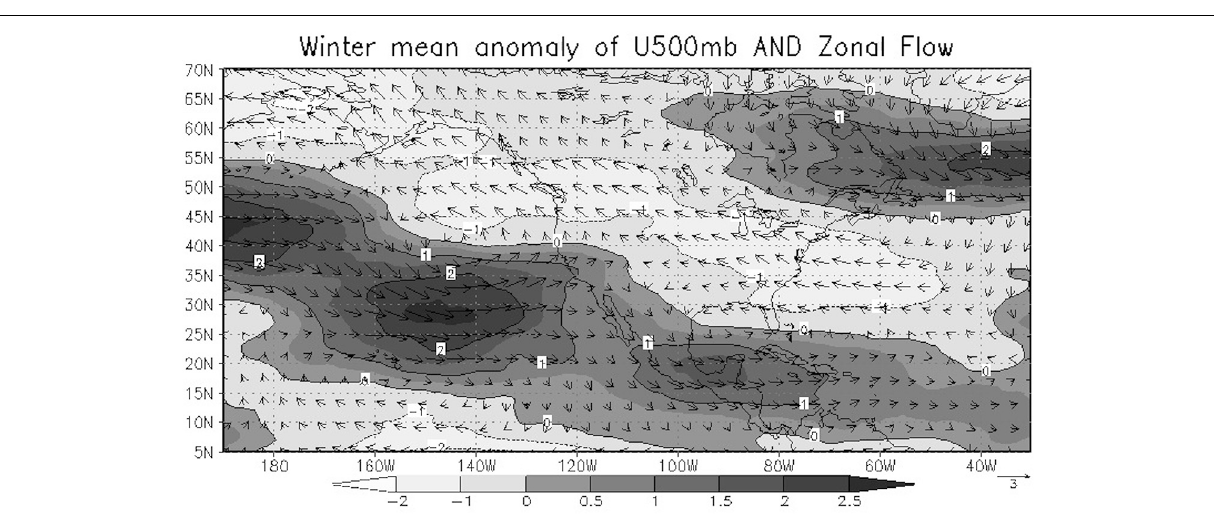
FIGURE 10 | Change of the 500hPa wind (ms − 1 ) field for the NH winter 2080–2089 relative to 1980–1989. Shades indicate the corresponding anomalies in the 500hPa zonal